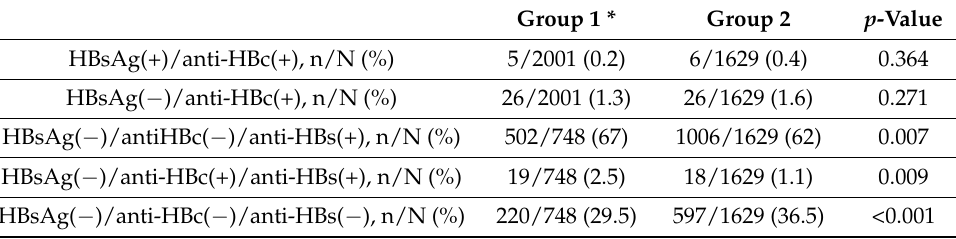
Table 2. HBV serologic markers among group 1 and group 2